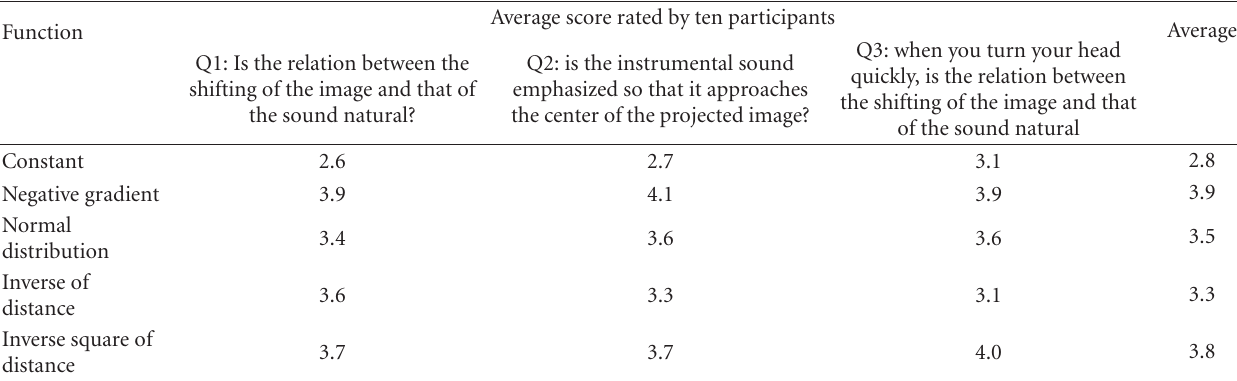
Table 2: Average score of each